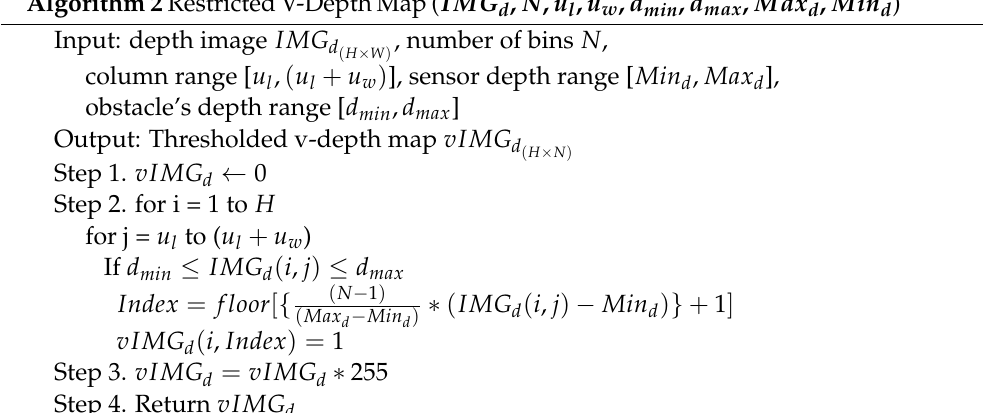
Algorithm 2 Restricted V-Depth Map ( IMG d , N , u l , u w , d min , d max , Max d , Min d